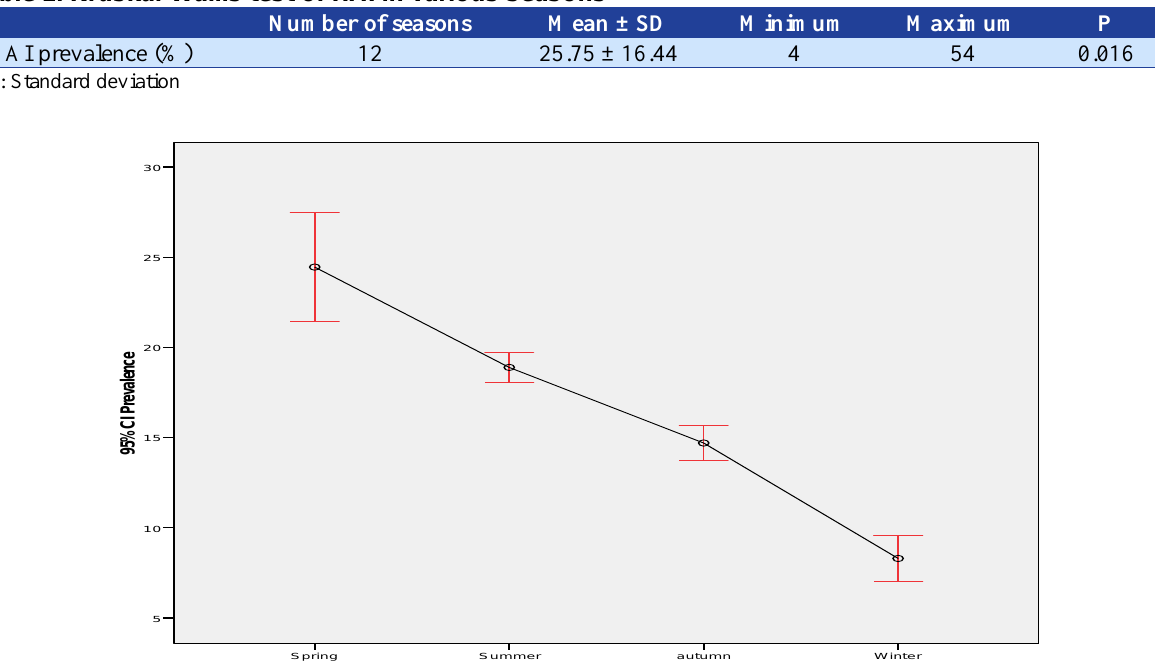
Figure 3. Hospital-acquired infection (HAI) prevalence (%) in each